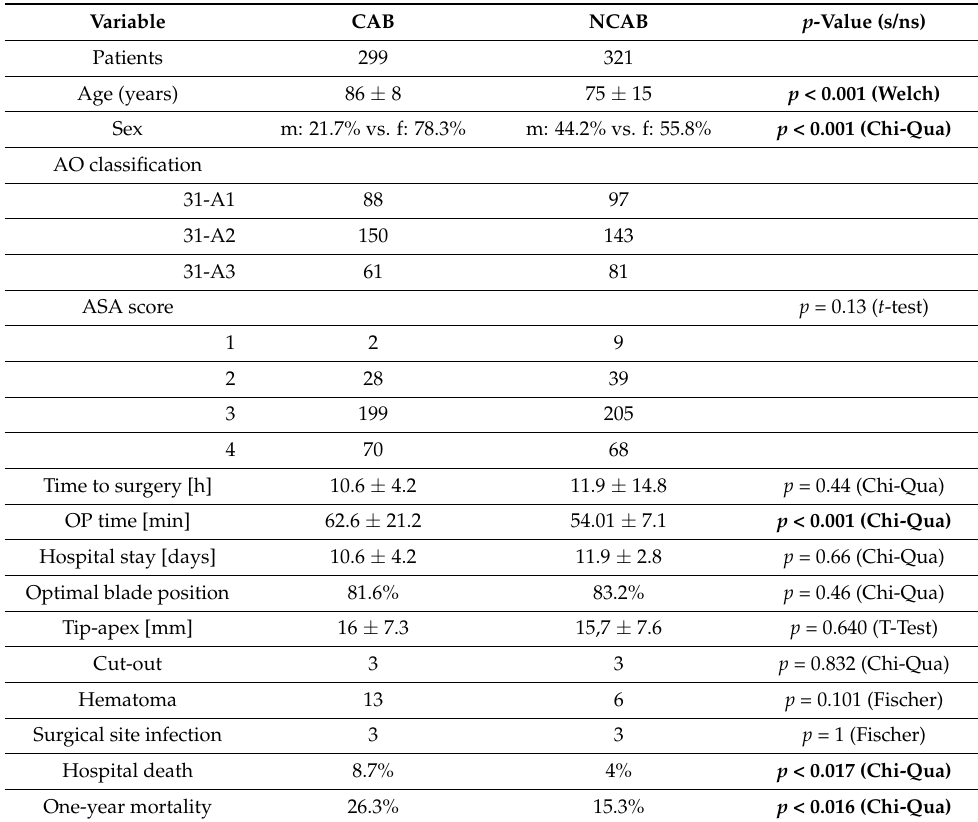
Table 1. Patient demographics.